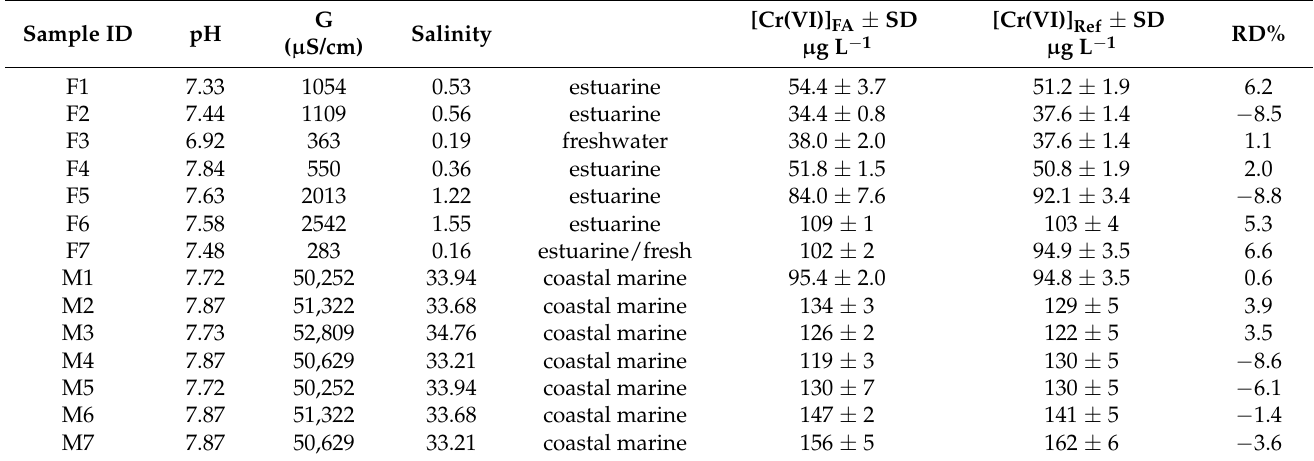
Table 3. Chemical parameters of the analyzed water samples and the results obtained with the developed flow-based system for Cr(VI) determination ([Cr(VI)] FA ) and with the reference procedure